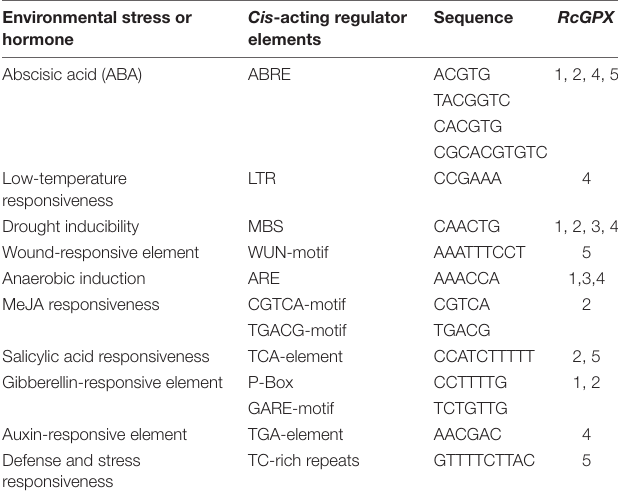
TABLE 2 | Putative cis -acting regulatory elements associated with stress and hormone responses in RcGPX promoters. Environmental stress or hormone